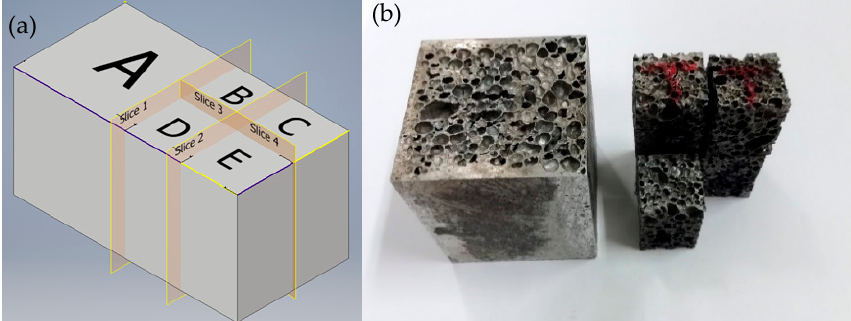
Figure 1. ( a ) Scheme of the ingot sectioning and ( b ) macrograph of the ingot after sectioning. Samples were cut minimizing cell wall damage. The surfaces were painted using a black dye in order to improve the contrast that must be high for performing image analysis. The specimens were ground by using SiC papers and polished with 1 μ m and 0.3 μ m